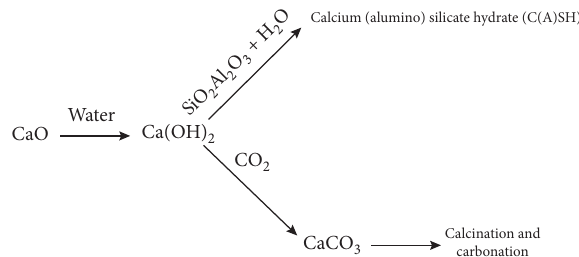
Figure 4: Specific reaction paths for hydration, calcination, car- bonation, and pozzolanic reactions of soil